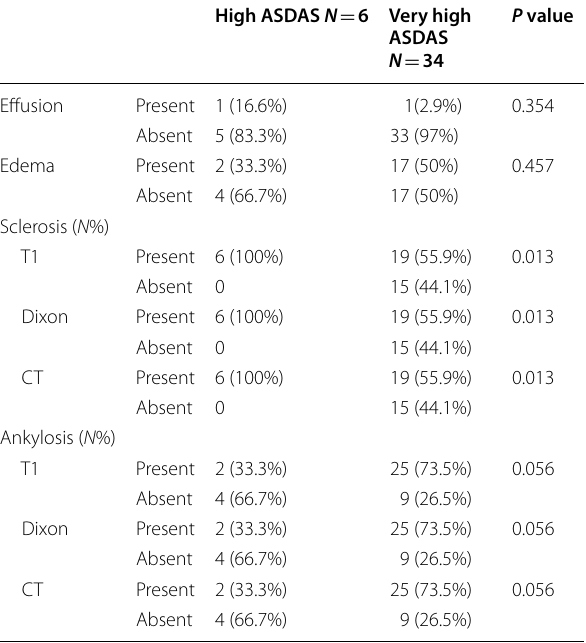
Table 4 Comparison between high ASDAS and very high ASDAS values